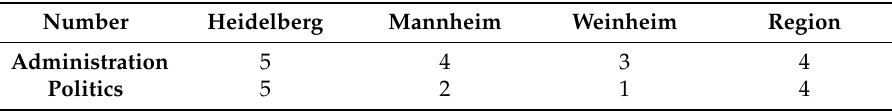
Table 1. Interview